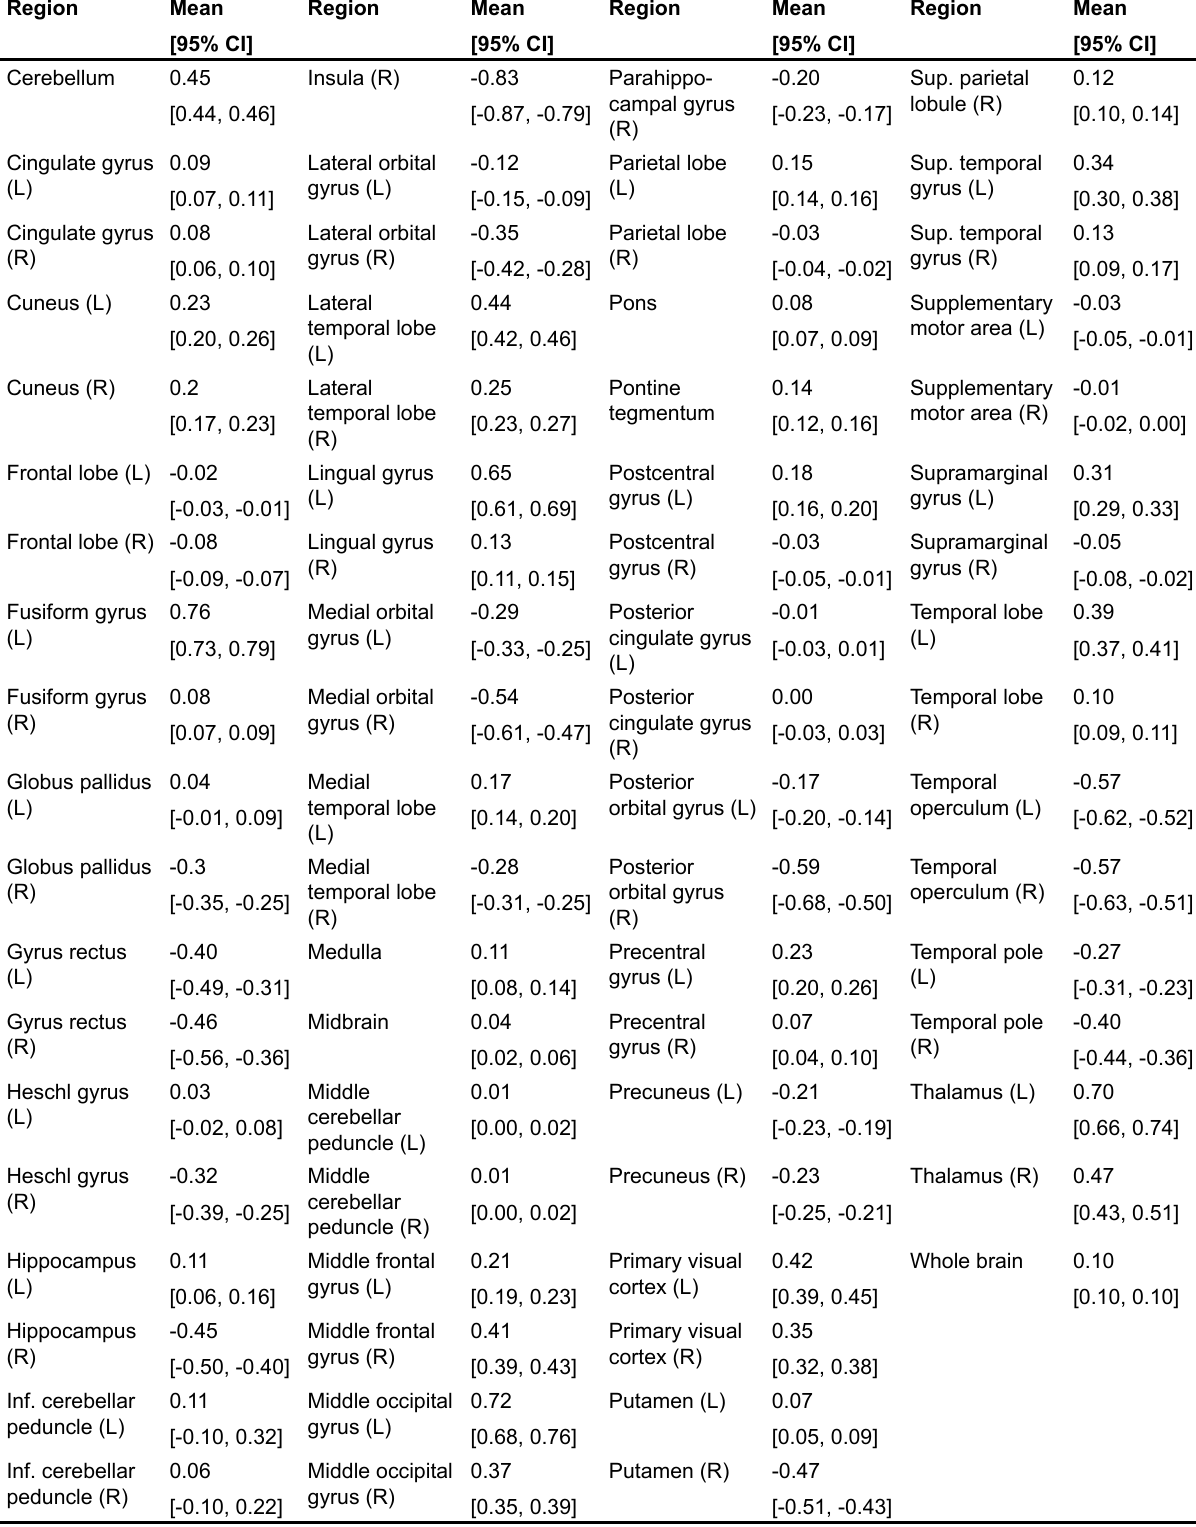
Table 3. Mean z-scores and 95% CIs quantifying the population template’s deviation from MIMneuro ® ’s controls for every region in MIMneuro ® ’s proprietary atlas ( continued